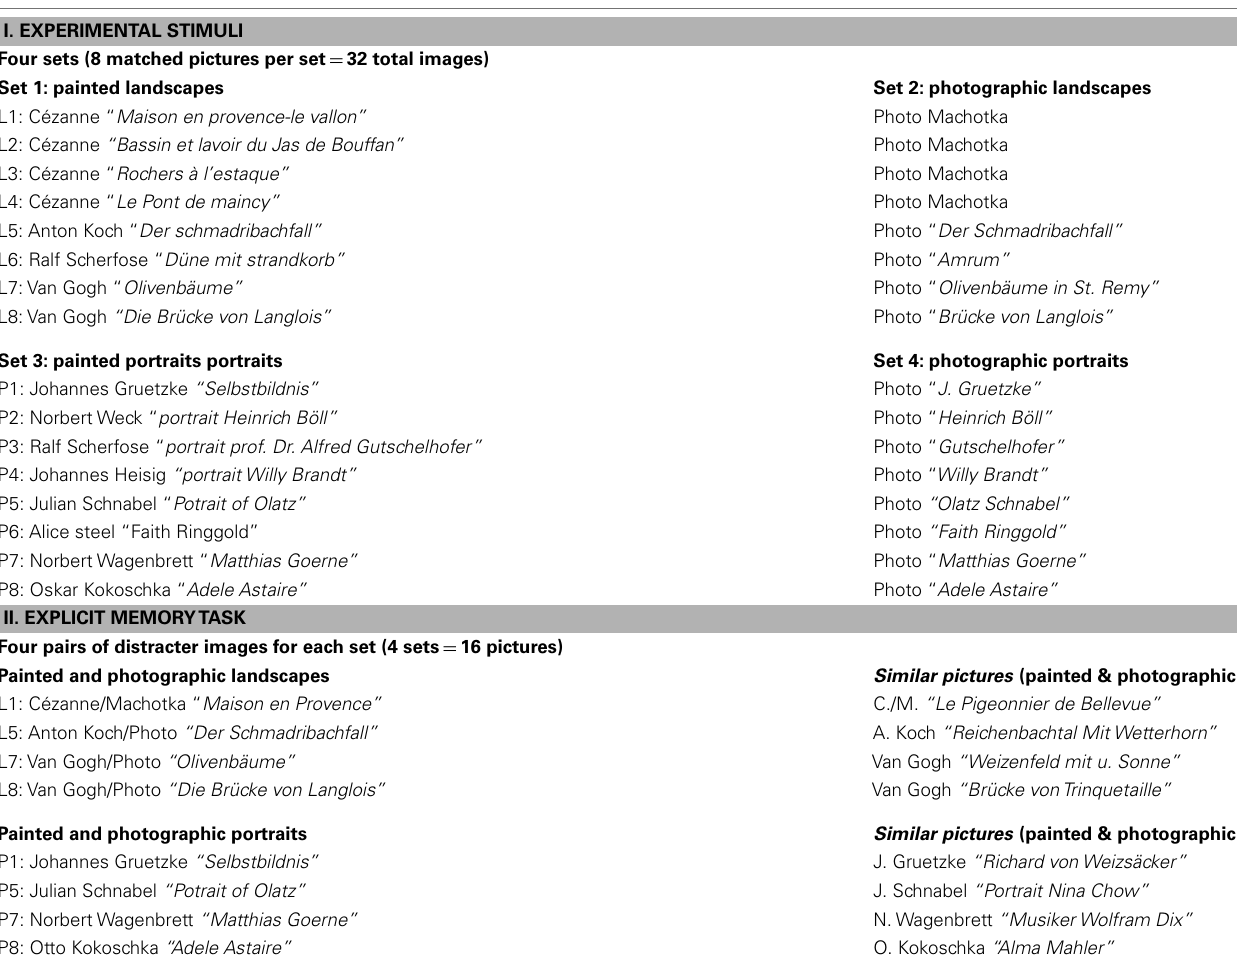
Table 1 | List of stimuli used in experimental task and explicit memory